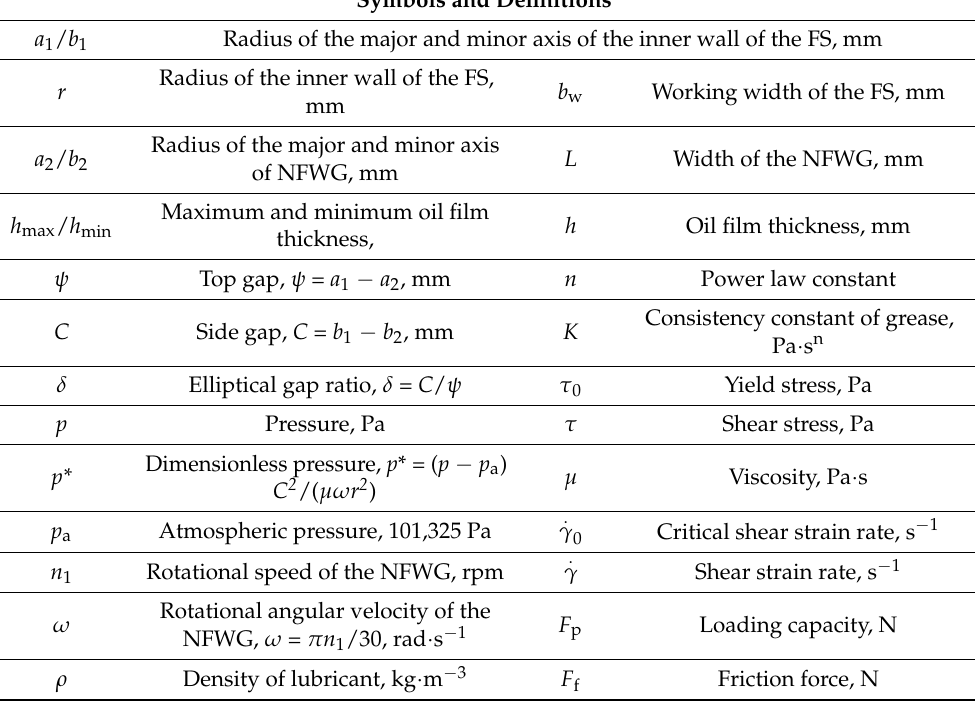
Table 1. Parameters and